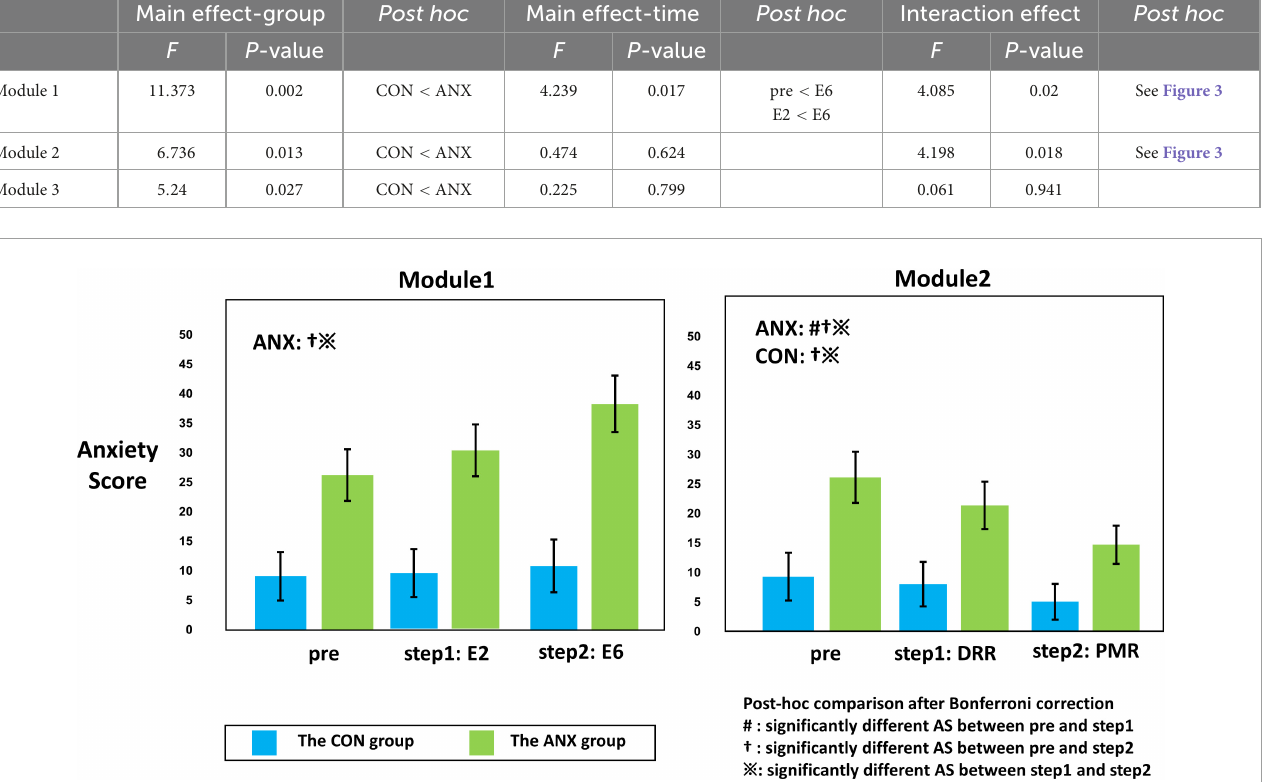
FIGURE3 Illustration of the interaction effect of group (ANX and CON) x time (pre, step 1, and step 2) obtained from repeated-measured analysis of covariance (ANCOVA). The adjusted value for sex, age, smoking usage, alcohol usage, and HADS-D are presented for each module. Error bars mean standard errors. The post hoc comparison of the significant ANCOVA results is also described within the plot. The symbols in the graph mean significantly different self-rating anxiety scores between pre and during (#), between pre and post (y), and between during and post ( ) from the post hoc comparisons with Bonferroni-corrected p < 0.05. AS, anxiety scores; DRR, diaphragmatic respiratory relaxation; PMR, progressive muscle